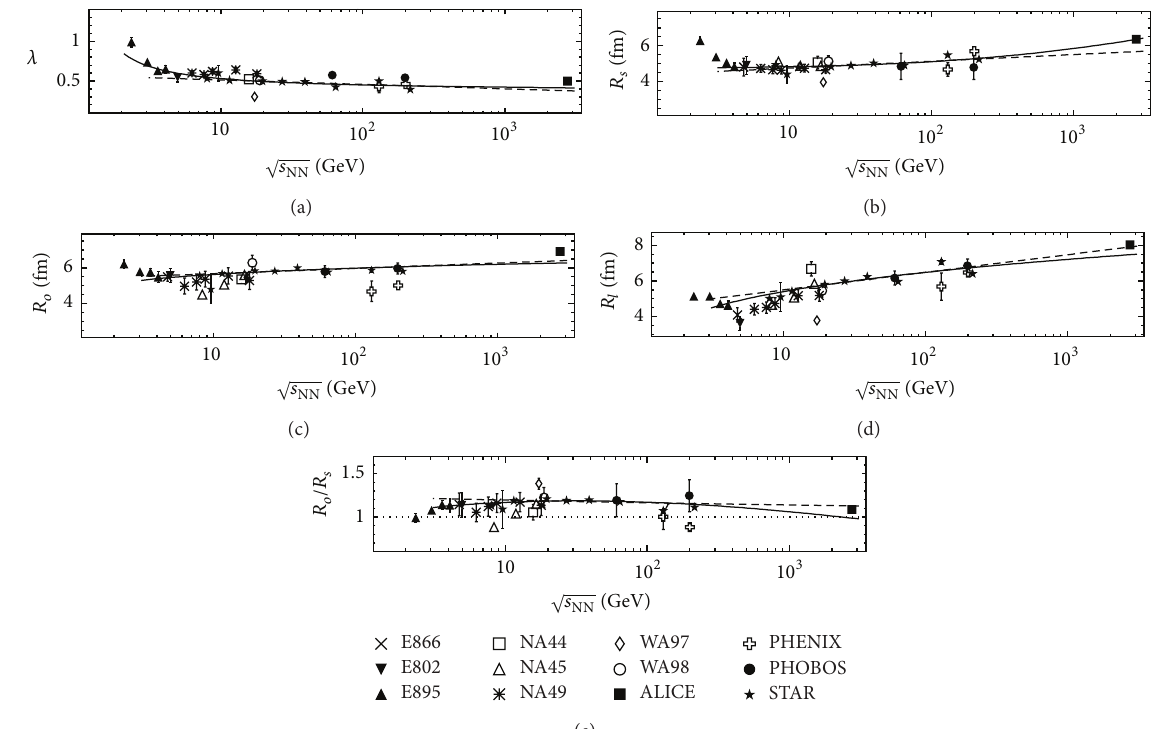
Figure 1: Dependence of chaoticity parameter (a), HBT radii (b–d), and ratio 𝑅 𝑜 /𝑅 𝑠 (e) on collision energy for central heavy ion Au + Au , Au + Pb , Pb + Pb interactions at midrapidity and ⟨𝑘 ⊥ ⟩ ≃ 0.2 GeV/ 𝑐 [6]. Experimental results are demonstrated for pairs of 𝜋 − mesons (in the cases = 7.7 – 62.4 and 200 GeV, for 𝜋 ± 𝜋 ± pairs) and for standard Coulomb correction 𝑃 (1) (𝑞) (in the cases of ALICE, of ALICE and STAR at √𝑠 𝐶 NN = 7.7, 11.5 – 62.4 and 200 GeV, for correction 𝑃 (3) NA44, NA45, PHOBOS, and STAR at √𝑠 𝐶 ). Statistical errors are shown (for NA44, total NN uncertainties). The solid lines (a–d) correspond to the fits by function (7) and dashed lines to the fits by specific case G 𝑖 1 ∝ ln 𝜀 , 𝑖 = 1 – 4 . Fitted data samples for 𝜆 (a) and for 𝑅 𝑙 (d) do not include the point of the WA97 experiment [11], while the fits for transverse HBT radii (b, c) are shown for samples with point from [11]. Smooth solid and dashed curves at (e) correspond to the ratio 𝑅 𝑜 /𝑅 𝑠 calculated from the fit results for 𝑅 𝑠 and 𝑅 𝑜 , and dotted line is the level 𝑅 𝑜 /𝑅 𝑠 = 1